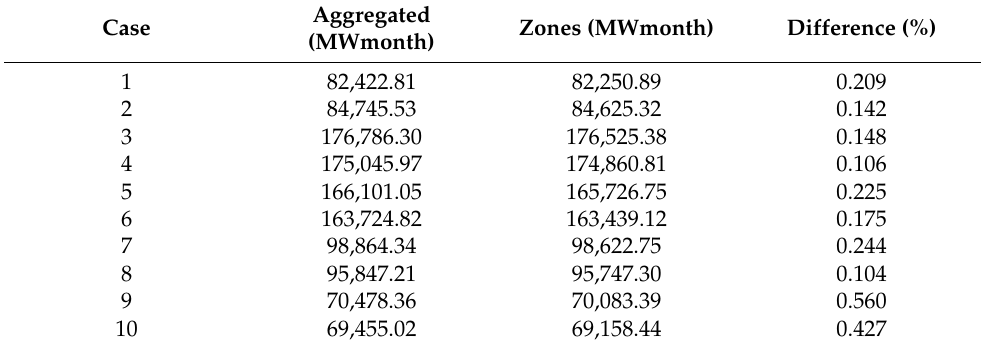
Table 5. Average total stored energy of the Brazilian system over the five trials of each case in MWmonth. One unit of MWmonth means that one MW can be generate continuously during one month. In this table, the relative difference in the stored energy is computed as 100 SE a is the total stored energy for the aggregated model in MWmonth, and SE z is the same metric for the zone